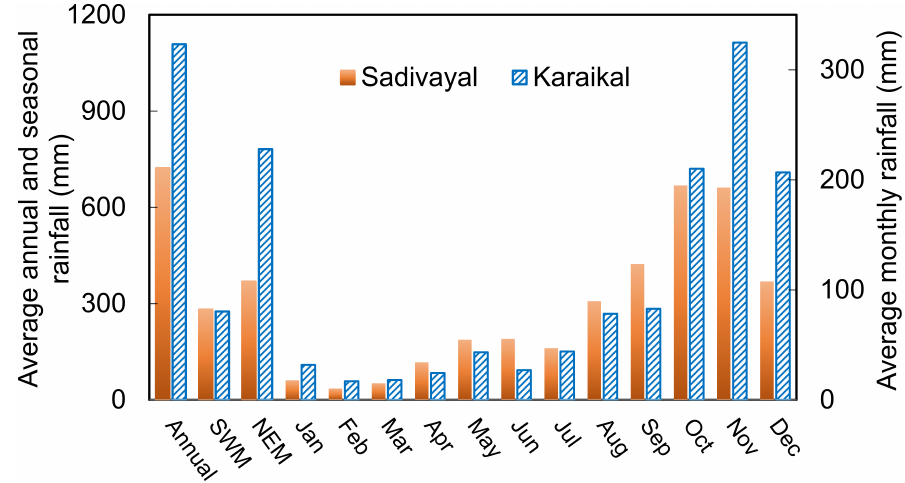
Figure 3. Comparison of annual, seasonal, and monthly rainfall in Sadivayal and Karaikal.